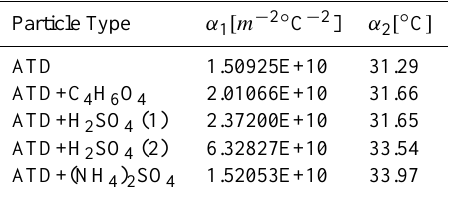
Table 2. Parameters α 1 and α 2 for the parameterization of n s (T ) for the immersion freezing of supercooled water droplets containing different types of